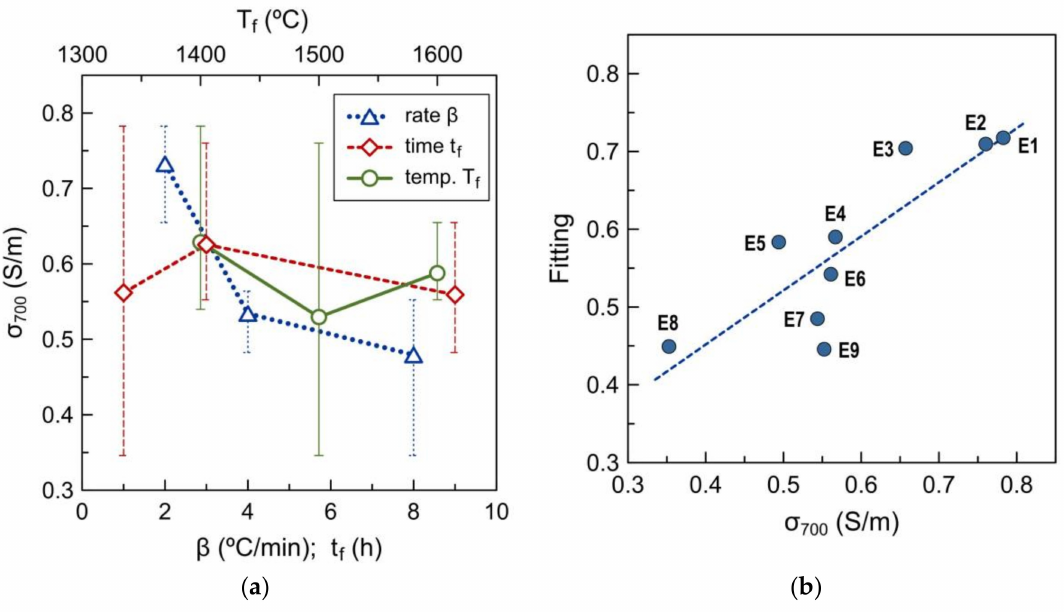
Figure 8. ( a ) Averaged dependence of electrical conductivity at 700 ◦ C on the rate of change in temperature, and sintering temperature and time.; ( b ) Multivariate fitting (Equation (3)) for the electrical conductivity at 700 ◦ C. Fitting parameters are shown in Table 3.